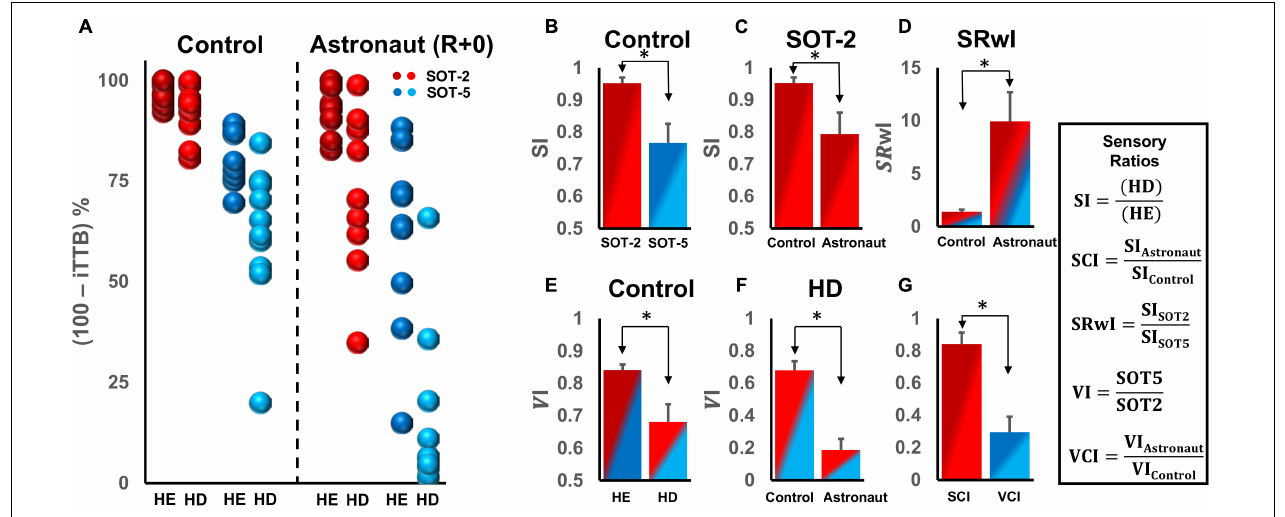
FIGURE 4 | (A) Comparison of postural control performance as (100 – iTTB) % in controls and astronauts on the return day (R + 0) for the two head and the two support surface tilt conditions. (B) Somatosensory index (SI) for the two support surface conditions for control subjects. (C) SI for control and astronaut subjects in SOT-2 condition on R + 0. (D) Somatosensory reweighing (SRwI) index for control and astronaut subjects. (E) Vestibular index (VI) for the two types of head conditions for control subjects. (F) VI for control and astronaut subjects in the HD condition. (G) The somatosensory change index (SCI) for SOT-2 and the vestibular change index (VCI) for HD. The color shading in bars (B–G) is based on colors used to represent raw data in (A) . ∗ p < 0.05.